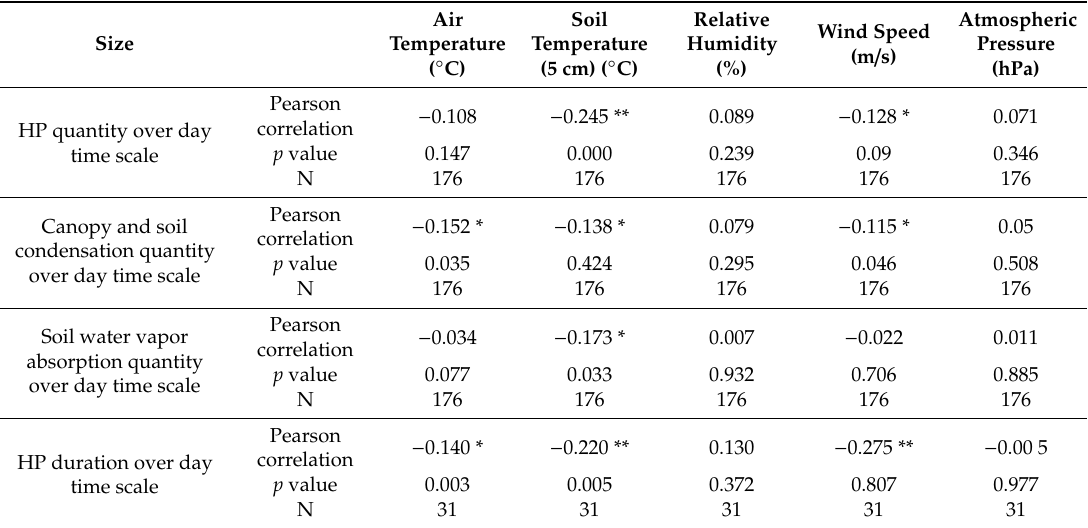
Table 3. The relationship between horizontal precipitation and meteorological